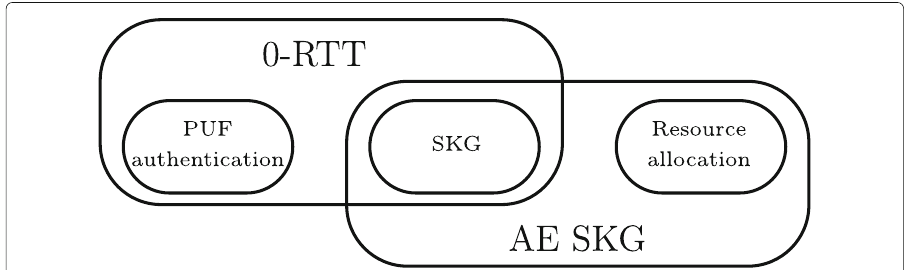
Fig. 1 Roadmap of